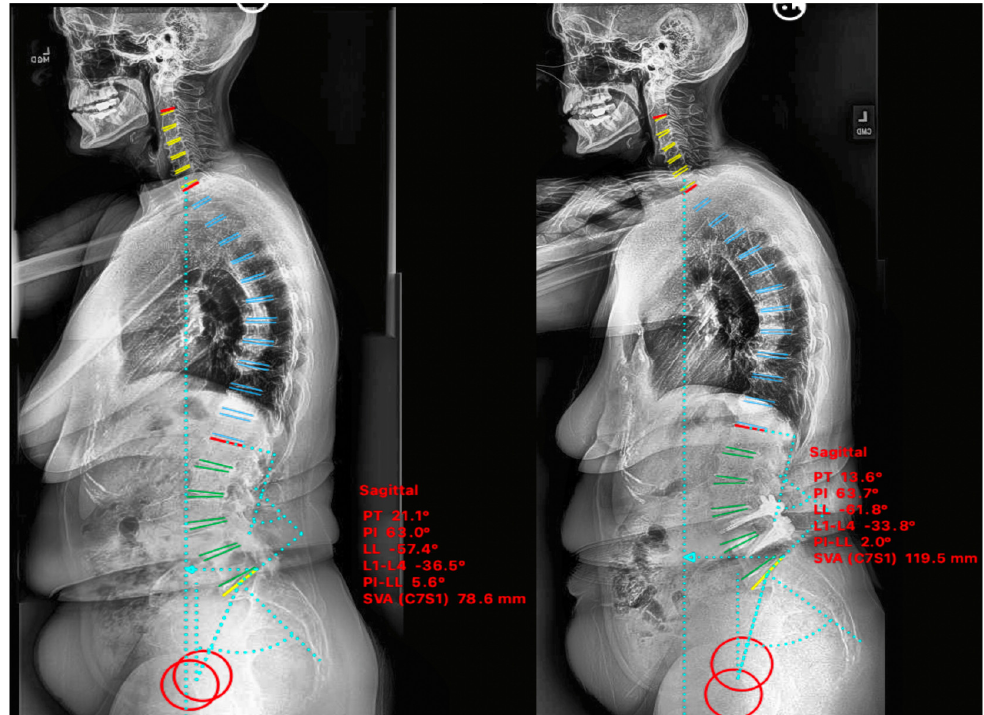
Figure 7. Case treated with pre-psoas interbody fusion for L4–5 spondylolisthesis without anterior column release and with a static titanium 8 ◦ cage. Lateral standing scoliosis radiographs. Pre-operative imaging ( left ), 3 months post-operative imaging ( right ). Note the worsening of sagittal plane imbalance but improvement of pelvic-incidence mismatch parameters post-operatively.